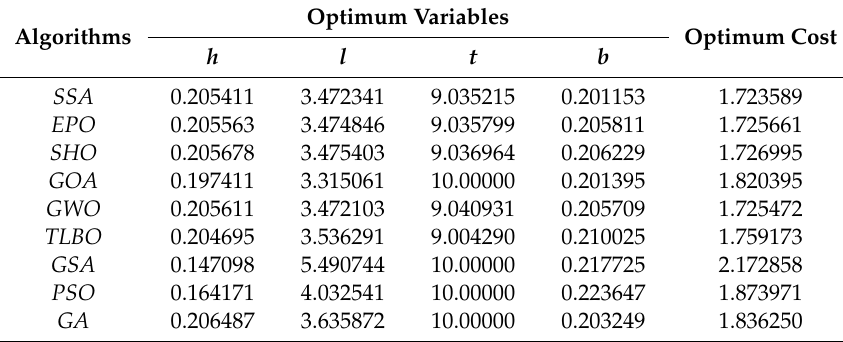
Table 9. Comparison results for welded beam design